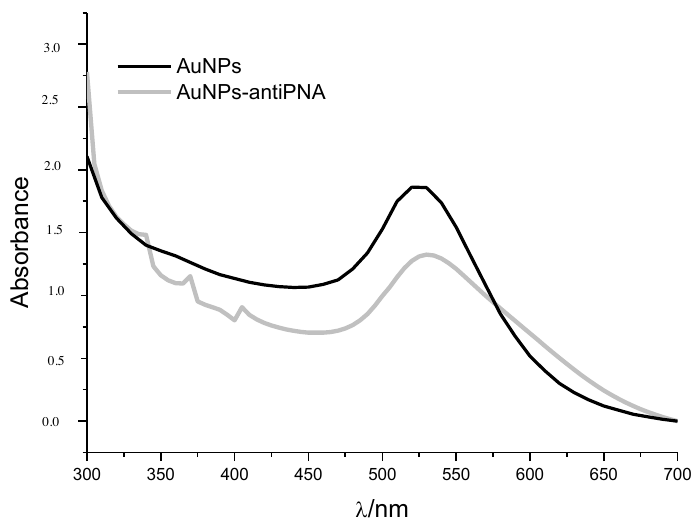
Figure 3. UV-Vis spectrum of gold NPs before (AuNPs) and after the functionalization with antibody anti-PNA